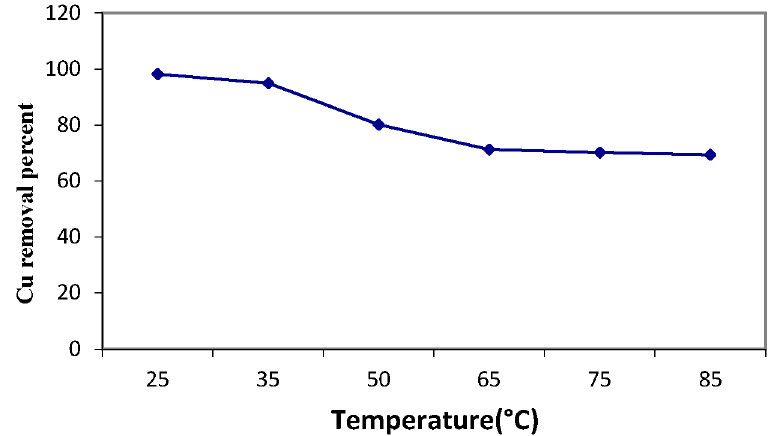
Figure 13. Effect of solution temperature on the copper sorption process using MANSG (solution concentration of ion = 1000 ppm; amount of MANSG = 0.25 g; agitation speed= 200 rpm; solution volume = 25 mL; pH = 7; time = 90 min).